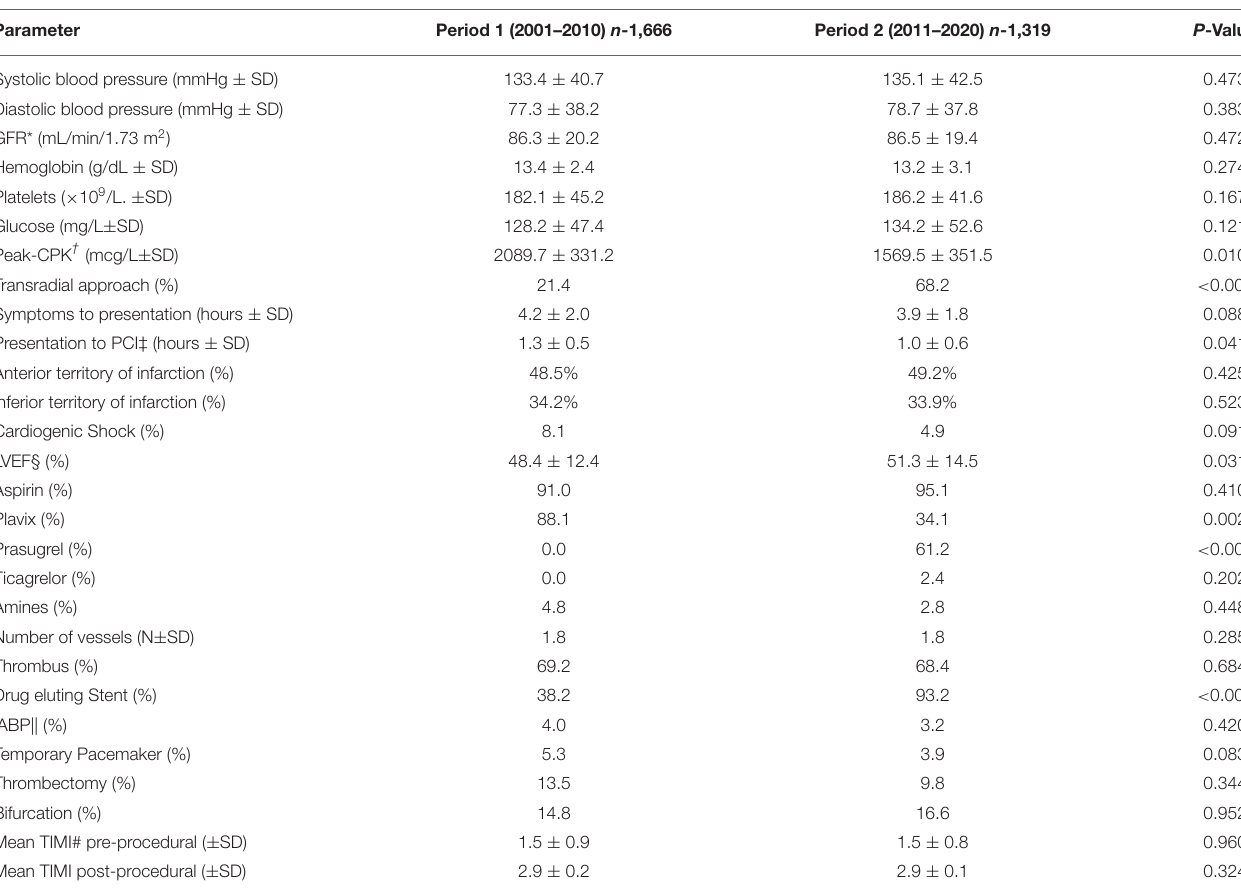
TABLE 2 | Presentation and procedural details according to